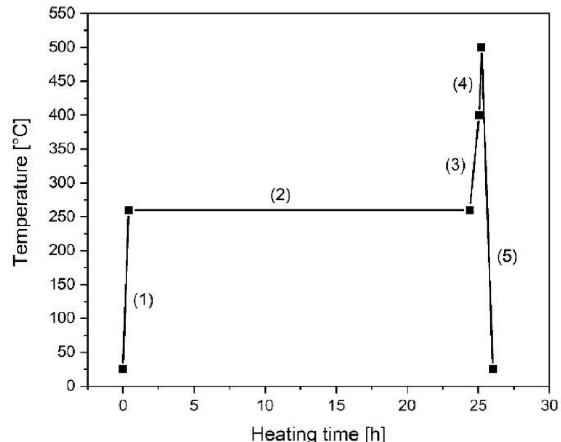
Figure A1. Temperature treatment program for the 35 nm-sized Al 2 O 3 nanoparticles. The particles were heated up to 260 °C with a heating rate of 10 K/min (1) and the temperature was maintained for 24 h (2). Then the temperature was increased to 400 °C with a heating rate of 5 K/min (3) and to 500 °C with 10 K/min (4). The cooling rate to room temperature was 10 K/min (5)